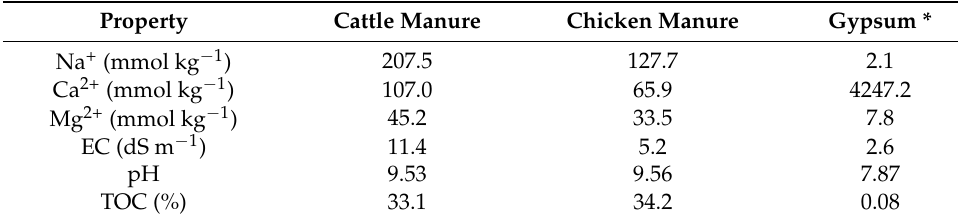
Table 2. Some pertinent properties of organic amendments and gypsum. Property Cattle